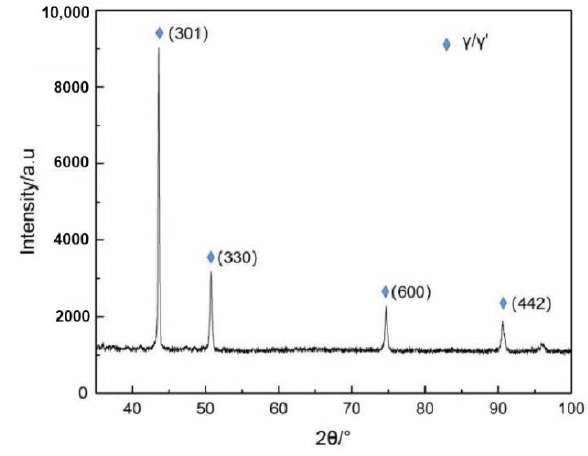
Figure 4. XRD diffraction pattern.